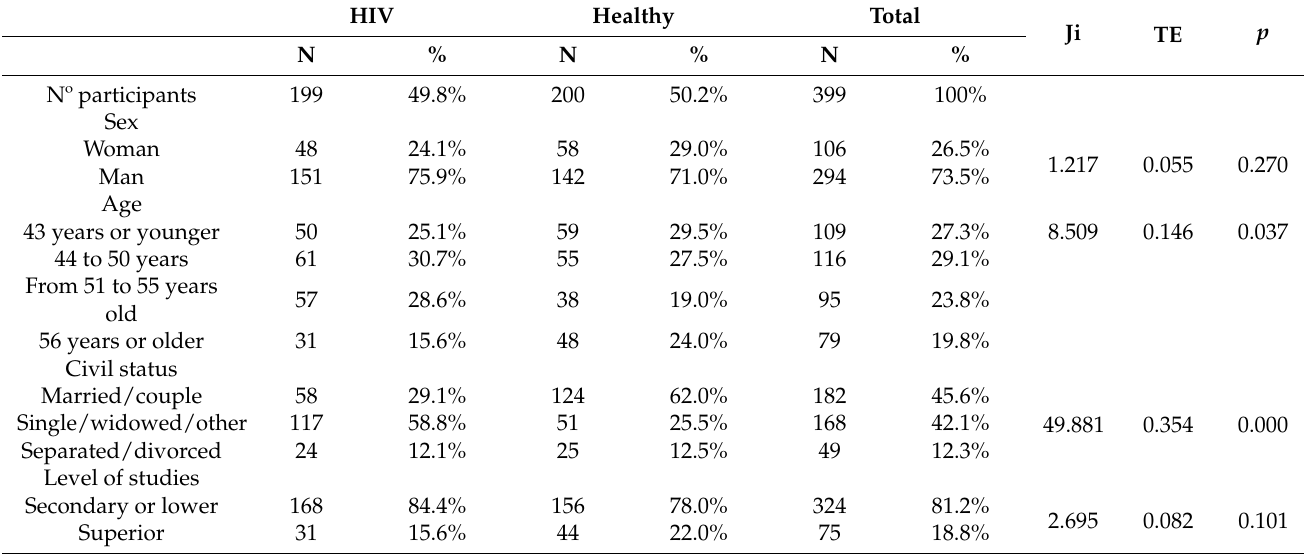
Table 4. Sociodemographic variables based on health status.